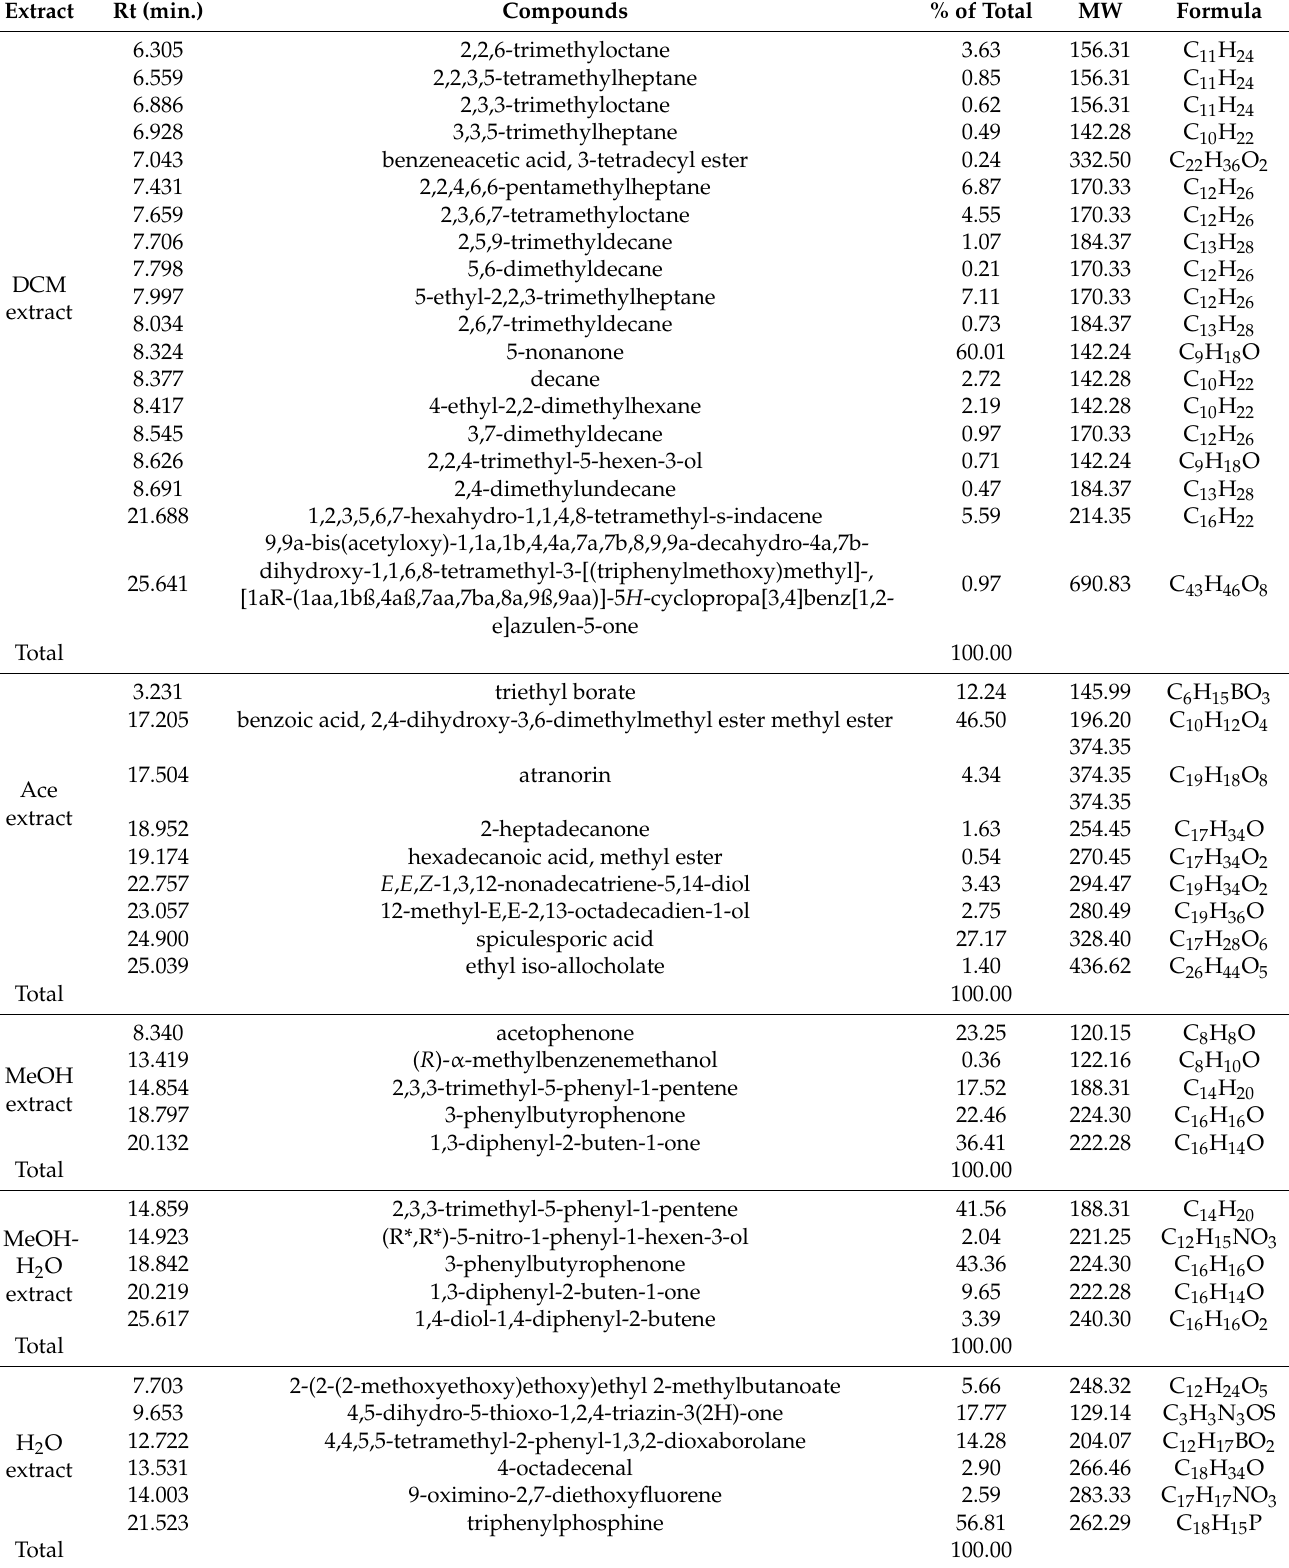
Table 1. Compounds identified in the extracts of P. glauca using